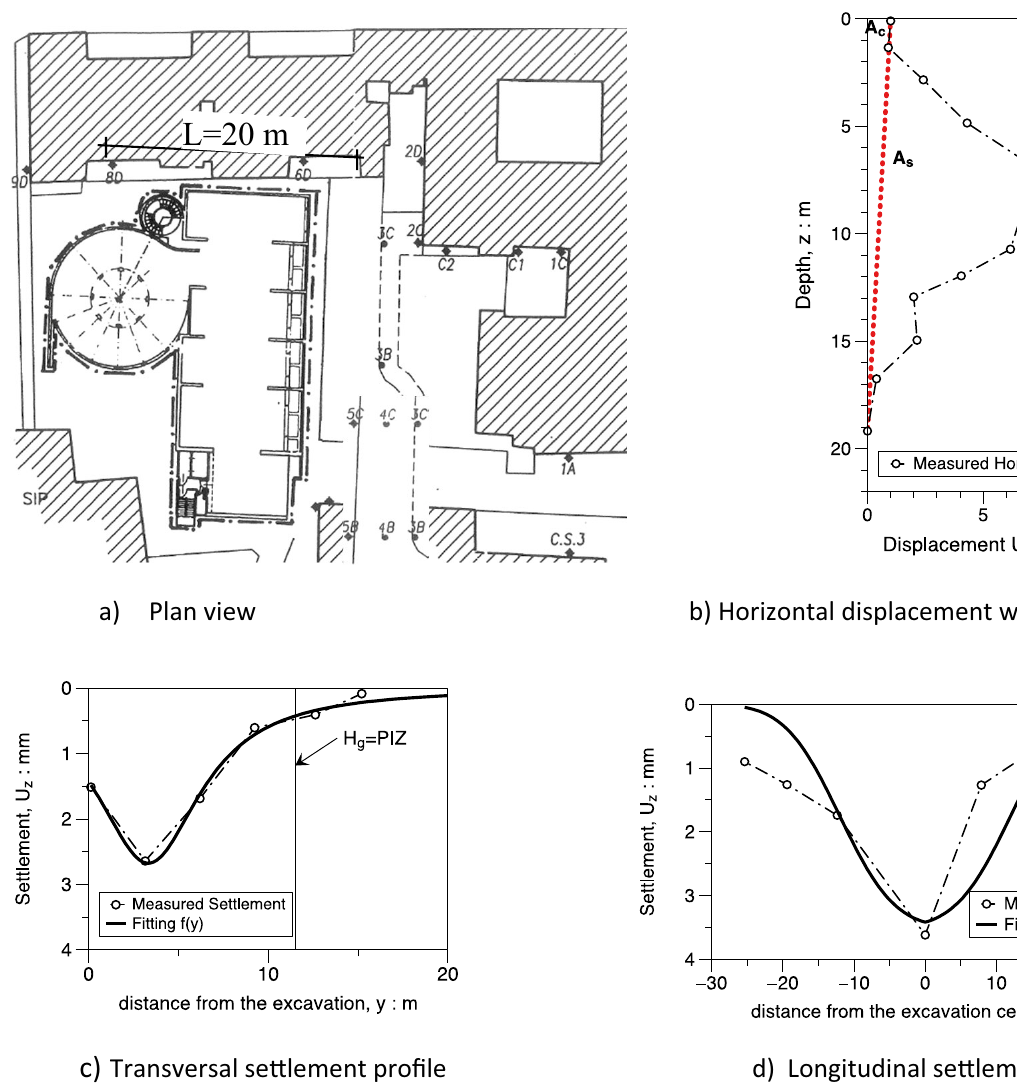
Figure 20. Plan view of the Montedidio site with Horizontal displacement and Settlement: comparison between predicted and measured behaviour (after Russo and Viggiani 39